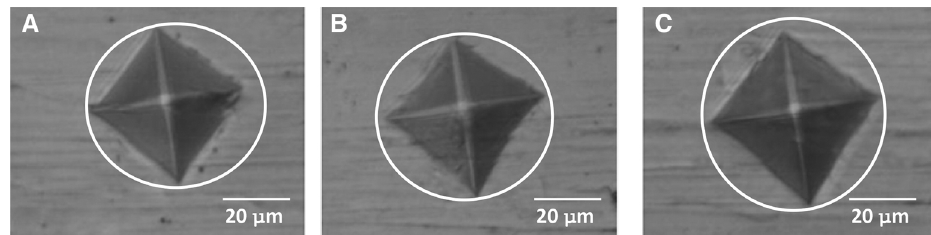
Figure 6: Indentation images of coatings produced (C) under optimum conditions with other conditions (A, B).